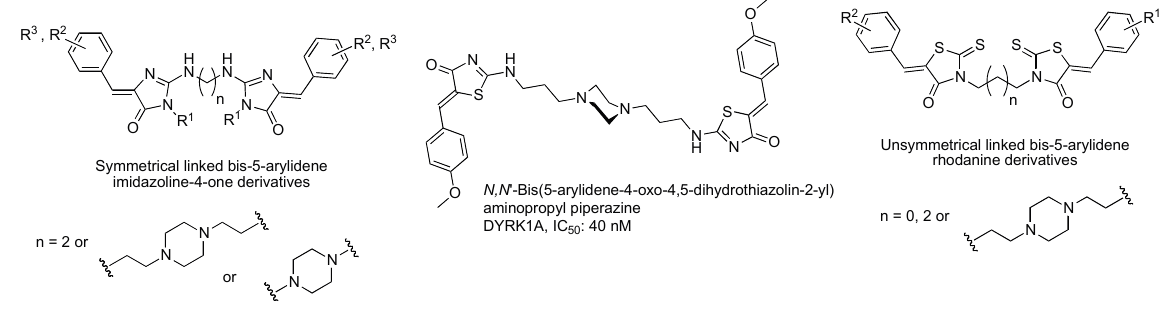
Figure 1. Symmetrical linked bis-5-arylidene imidazoline-4-ones, symmetrical linked bis-5-arylidene-1,3-thiazoline-4-ones and unsymmetrical linked bis-5-arylidene rhodanines derivatives (as inhibitors of the proteine kinase DYRK1A or against cell proliferation on cell tumor lines) identified and developed in our